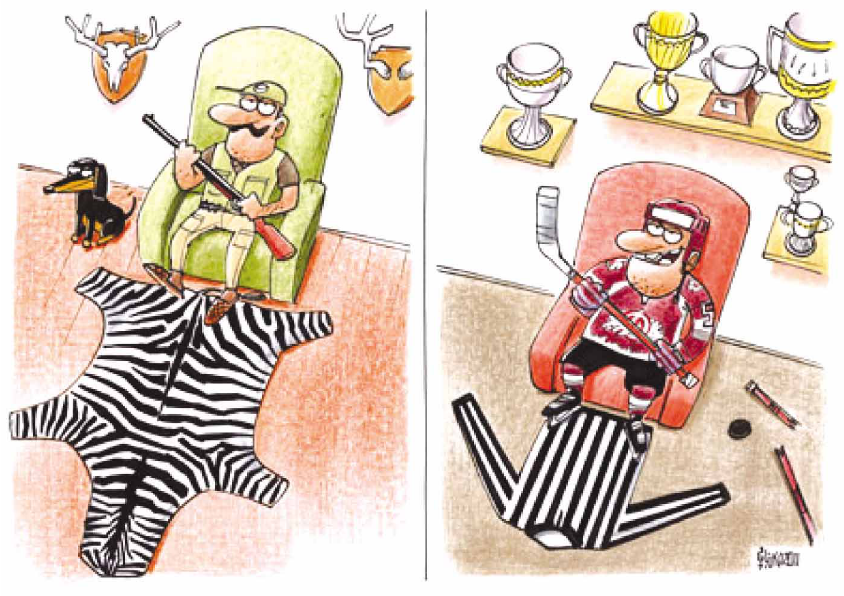
Fig. 3. Author: Gatis Š ļū